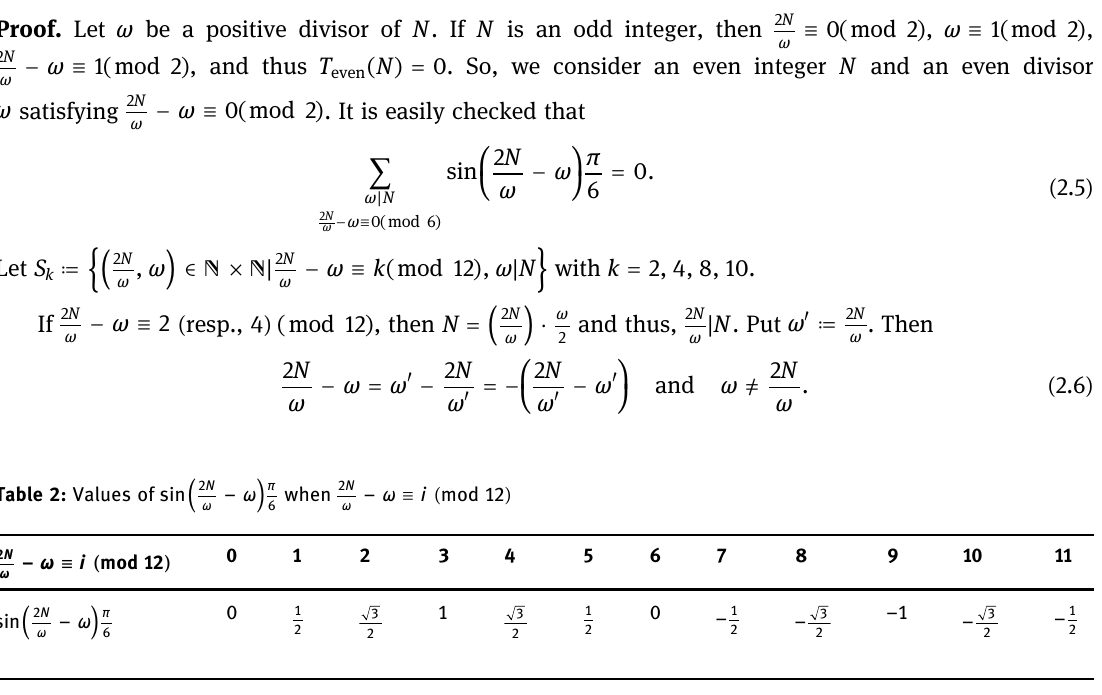
Table 3: Multiplicative operation table of ω ¯, ¯ N